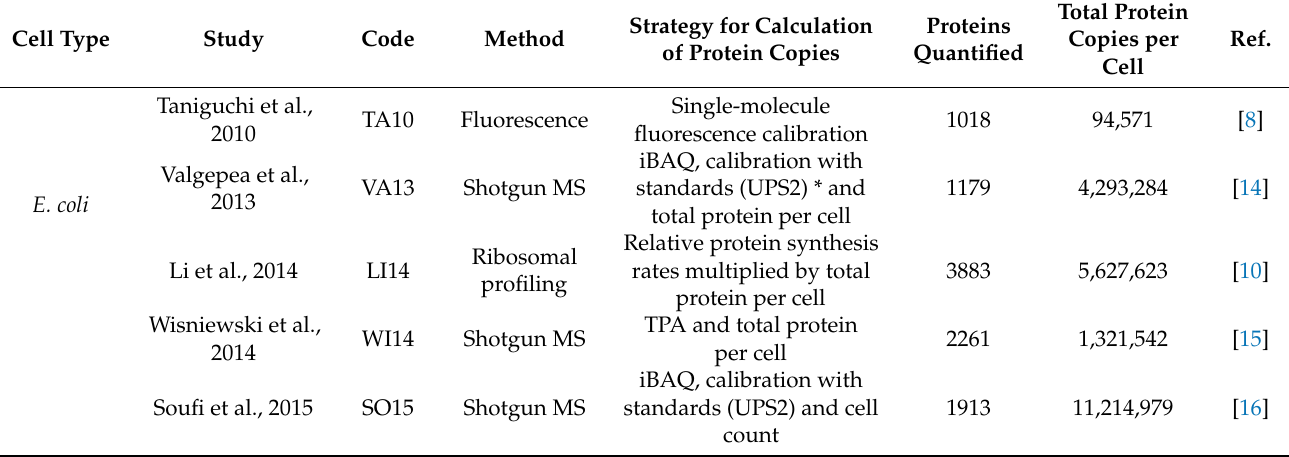
Table 1. Overview of selected proteomic studies of E. coli , S. cerevisiae , and